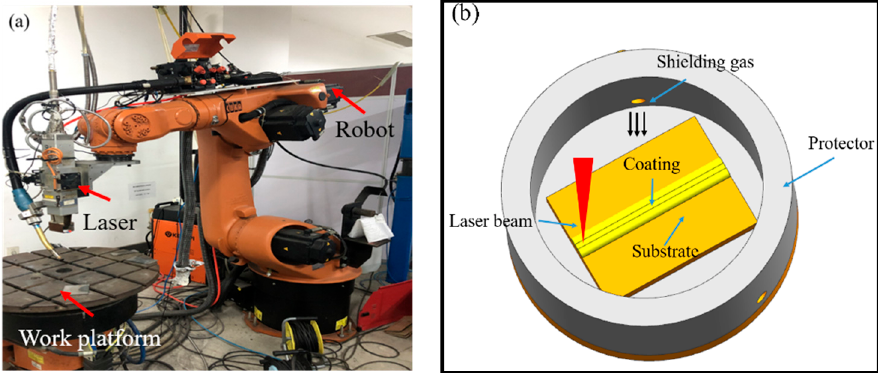
Figure 3. Laser processing system for laser cladding: ( a ) experimental equipment; ( b ) schematic illustration of the laser cladding process.